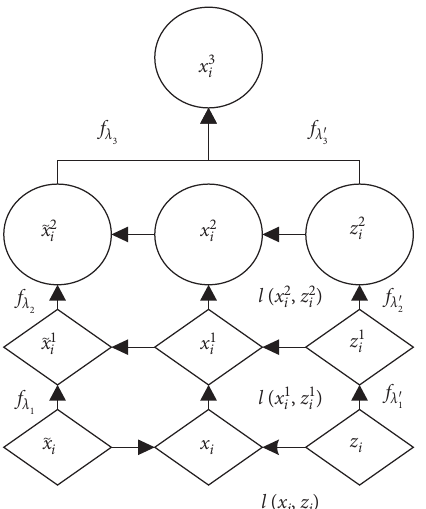
Figure 3: Three-layer sDSAE